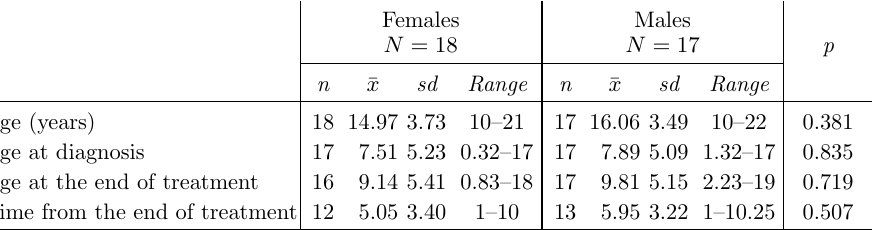
Table 1. Comparison of four variables connected with age in gender groups